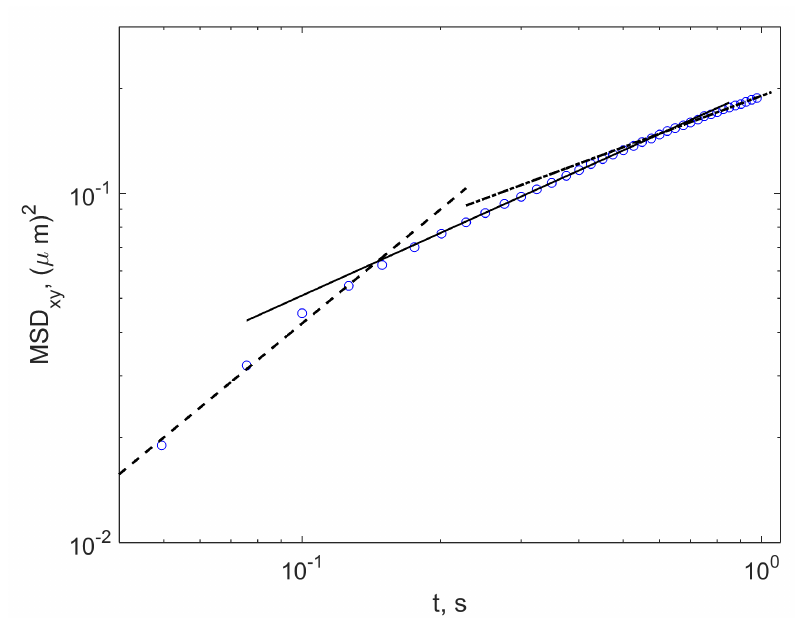
Figure 5. The digitized data for 2D movements in the laboratory frame (markers) taken from [51], dig- itized and replotted in double logarithmic co-ordinates. The straight lines indicated the power-law de- pendencies MSD xy ∼ t α with α = 1 (dashed line), α = 0.6 (solid line), and α = 0.5 (dash-dotted